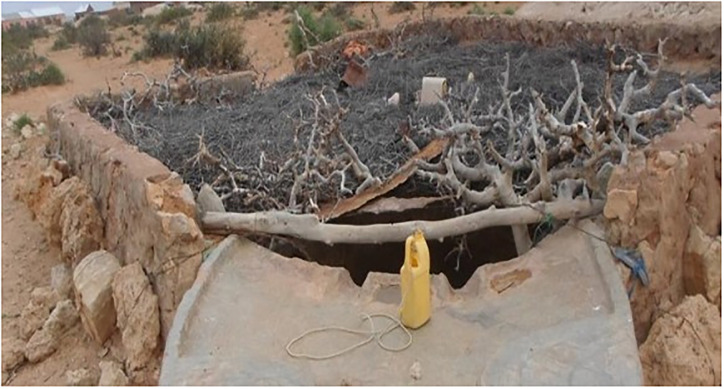
Picture of a berkad.